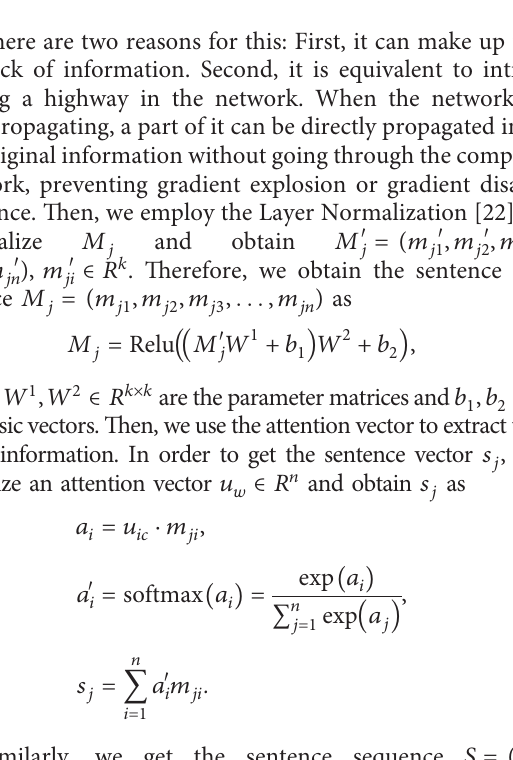
Figure 2: General THME framework. Trm denotes the Transformer, and RE denotes the regular expression. u in the i -th sentence; u s 1 , u s 2 , u s 3 represent attention vectors which extract textual features of three subtasks of LJP (T) 1 , T 2 , T 3 from sentence- level sequence; and u s 4 represent attention vectors which extract textual features of case’s conclusions ( T ) 4